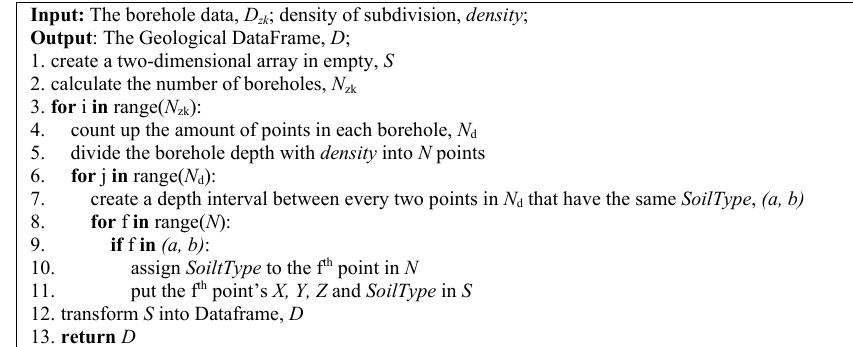
Figure 2 . D can be represented through point cloud modelling with X , Y , Z parameters input and keeping the orders.